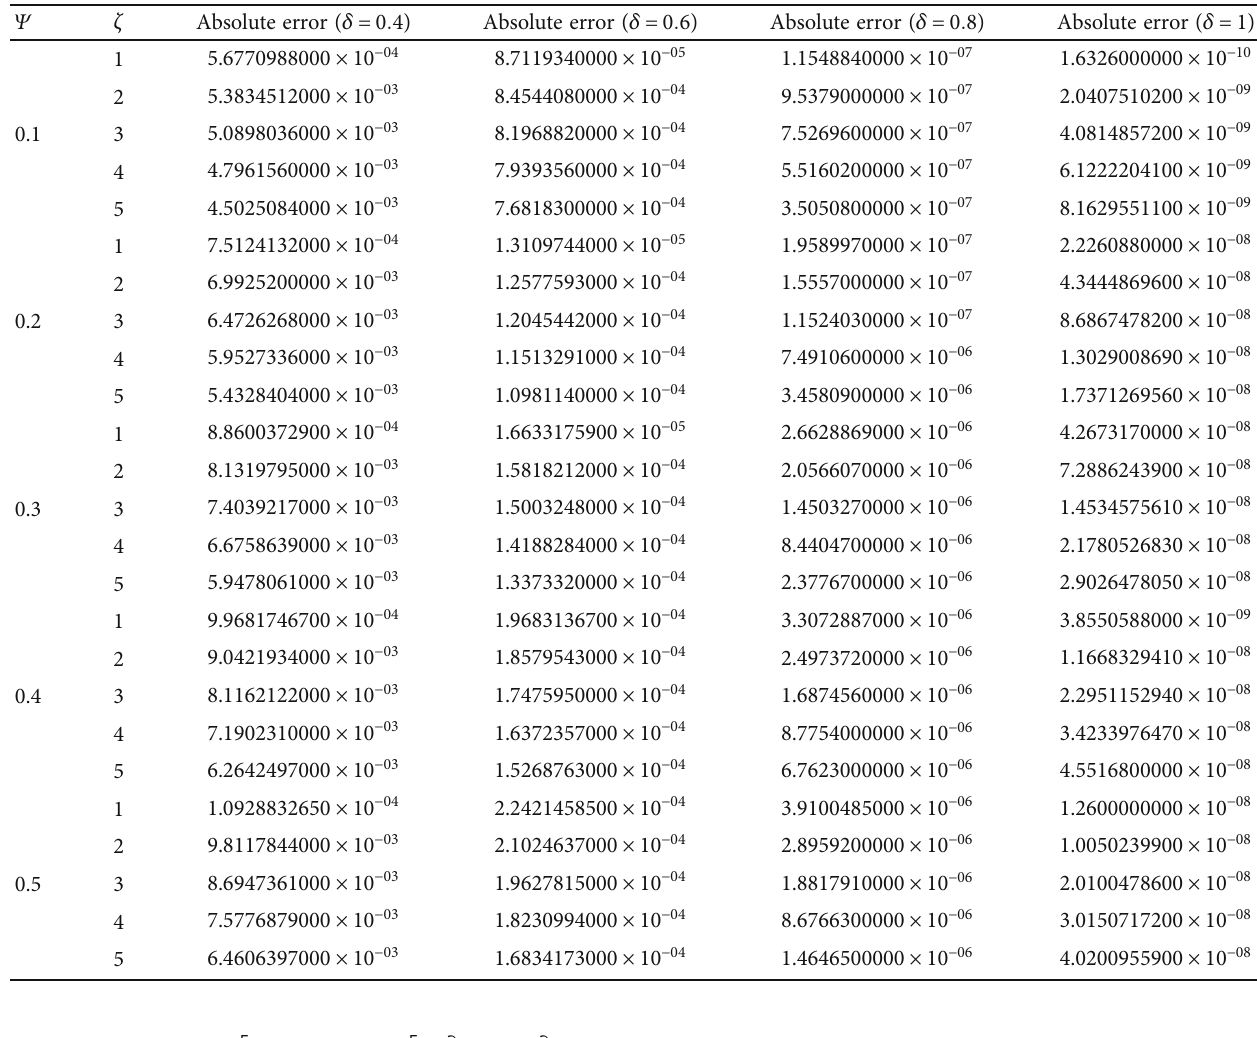
Table 3: YDM-solutions of example 2 at ν ð ζ , Ψ Þ di ff erent fractional-order of δ